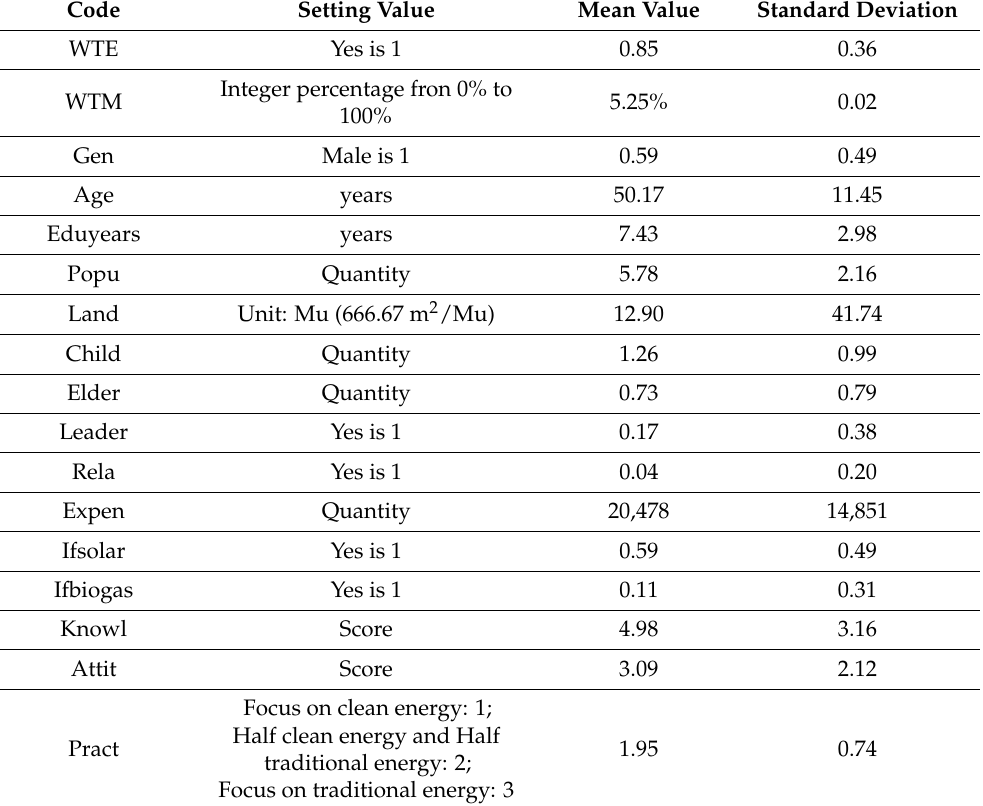
Table 2. Descriptive